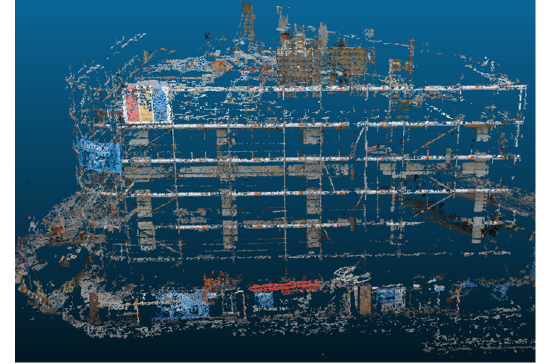
Figure 7. Dense point cloud created from the images shown in Figure 6.